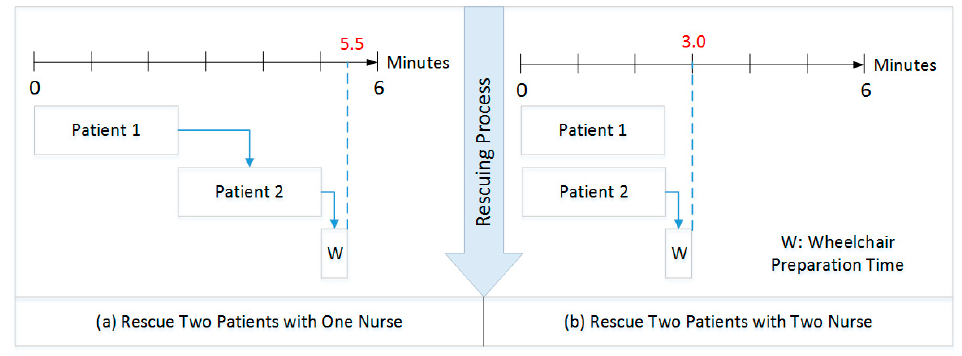
Figure 5. Two stochastic behaviors of nurses will result in two different outcomes.